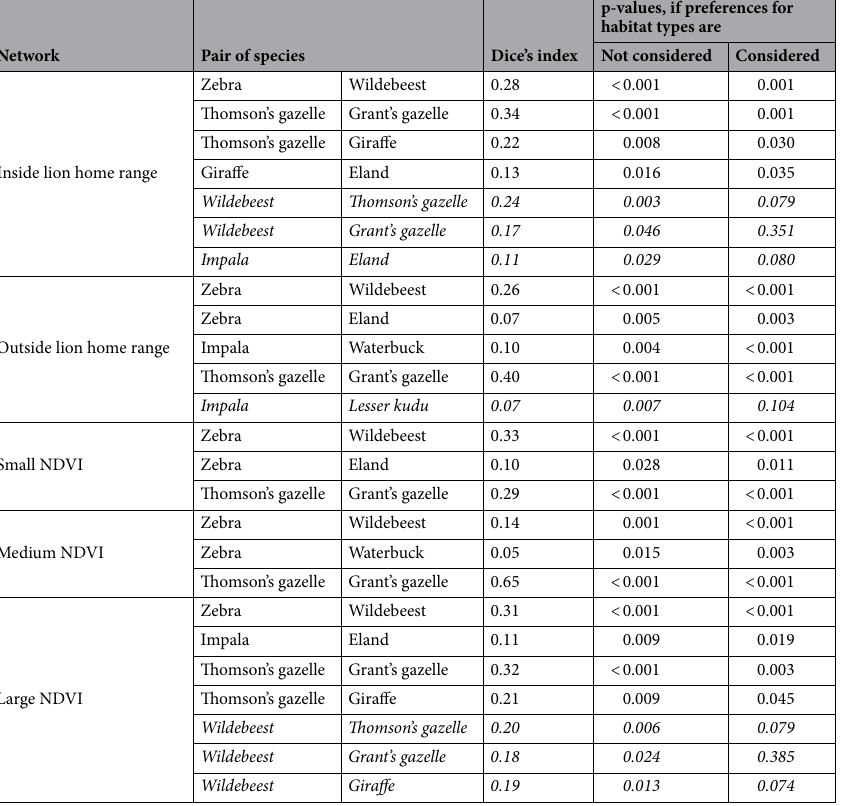
Table 3. Dice indices for species dyads and results of randomisation tests (10 7 steps; described in the “Methods” section) testing the strengths of dyadic associations observed in the five networks. In some cases, the significance of the association strength can be explained by preferences for the same habitat types (lines highlighted in italics). For each scenario, all dyadic associations between the ten most frequently encountered species (giraffe, eland, zebra, wildebeest, waterbuck, lesser kudu, Grant’s gazelle, impala, Thomson’s gazelle, Kirk’s dik–dik) were tested. Only dyads with significant values are